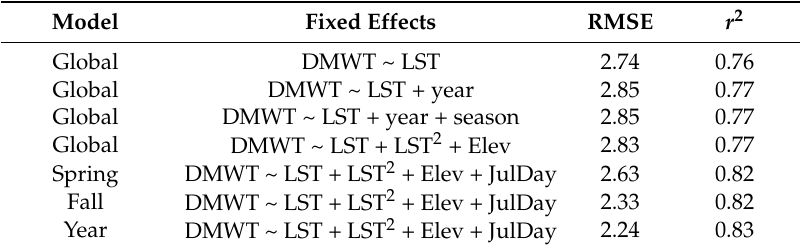
Table 3. Model comparison of global models built including all sites across all years, those including year and season terms, and those split into two datasets based on the highest DMWT across each year (“Spring” and “Fall”). “Year” models are the mean metrics for models built on each year’s data (including a seasonal split). Model RMSE